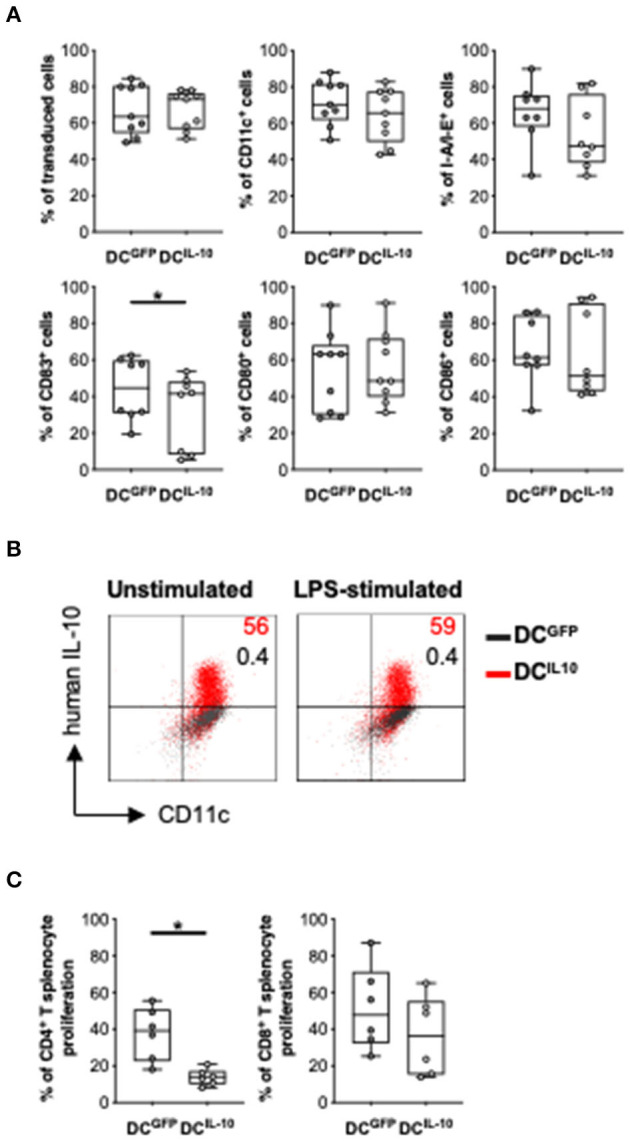
In vitro characterization of murine DCIL−10. Female Balb/c BM cells were differentiated into DC, transduced at day 2 with LV-GFP (DCGFP) or LV-IL-10 (DCIL−10), and activated with LPS (200 ng/ml) during the last 2 days of differentiation. (A) Transduction efficiency was quantified based on ΔNGFR expression and the expression of the indicated markers was analyzed at day 9 of differentiation by flow cytometry. Each dot represents a single experiment (n = 8–9), lines indicate median, while whiskers are minimum and maximum levels. (B) DC were plated and left unstimulated or stimulated with LPS (200 ng/ml) for 24 h, with the addition of brefeldin A at 6 h. The expression of human IL-10 was quantified by intracytoplasmic staining. One representative donor out of two is depicted, and percentages of positive cells are indicated. (C) Spleen cells from female C57Bl/6 mice were stained with a proliferation dye and stimulated with Balb/c DCGFP and DCIL−10 at 1:10 ratio. At day 5, proliferation of CD4+ and CD8+ T cells was measured by flow cytometry. Each dot represents a single donor (n = 6), lines indicate median, while whiskers are minimum and maximum levels. *P ≤ 0.05 (Wilcoxon matched pairs test, two-tailed).